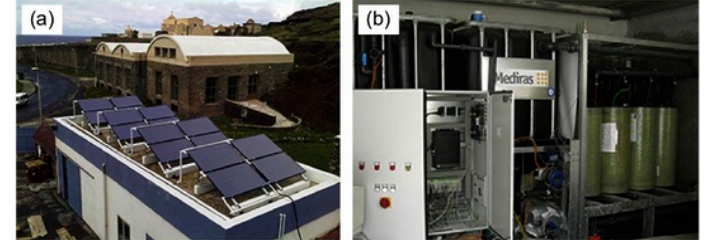
Figure 9. MEDIRAS project MD pilot plant installed in Pantelleria, ( a ) PV systems; ( b ) desalination plant pilot obtained from Viola [16], with permission Licensed under CC BY-NC 4.0 from International Journal of Heat and Technology, 2016.